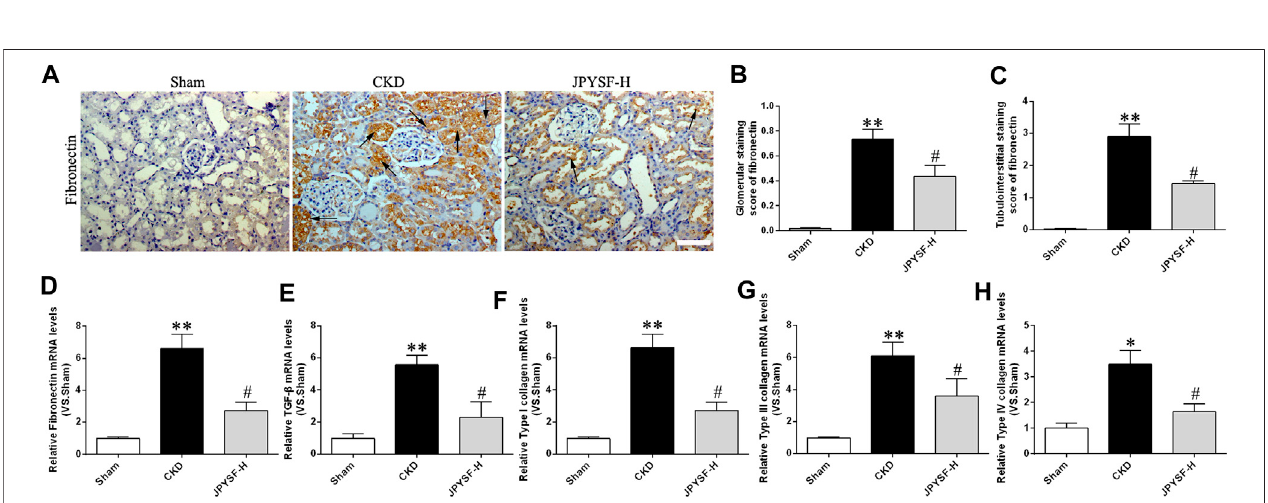
FIGURE 2| JPYS formula ameliorates renal fi brosis in CKD rats. (A) IHC staining of fi bronectin in the kidney ( × 200, scale bar (cid:2) 100 μ m). Fibronectin-positive areas are indicated by arrows. (B) Glomerular and (C) tubulointerstitial staining score of fi bronectin. Relative mRNA expression levels of fi bronectin (D) , TGF- β (E) , type I collagen (F) , type III collagen (G) , and type IV collagen mRNA (H) . All data are expressed as means ± SEM. ** p < 0.01 vs. the sham group; # p < 0.05 vs. CKD group.